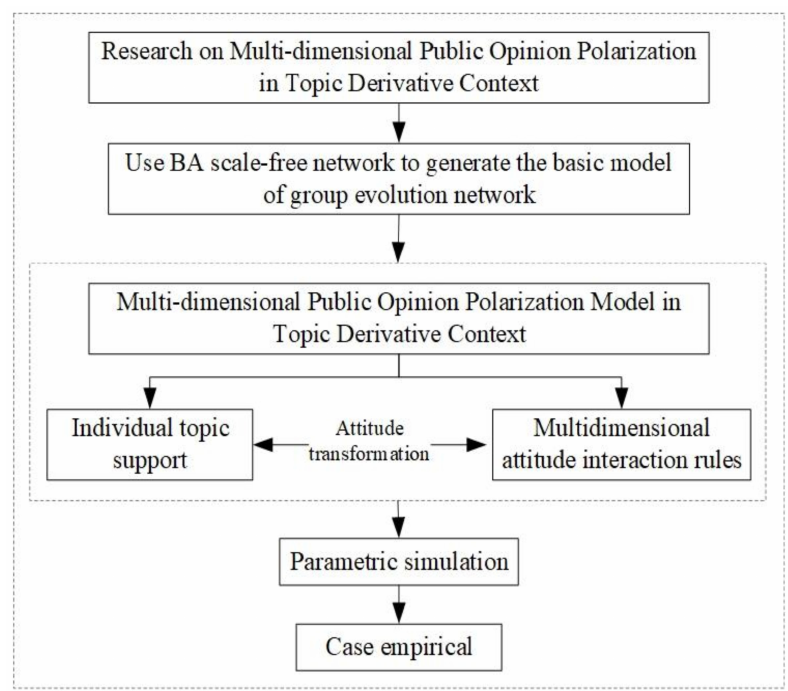
Figure 1. Research